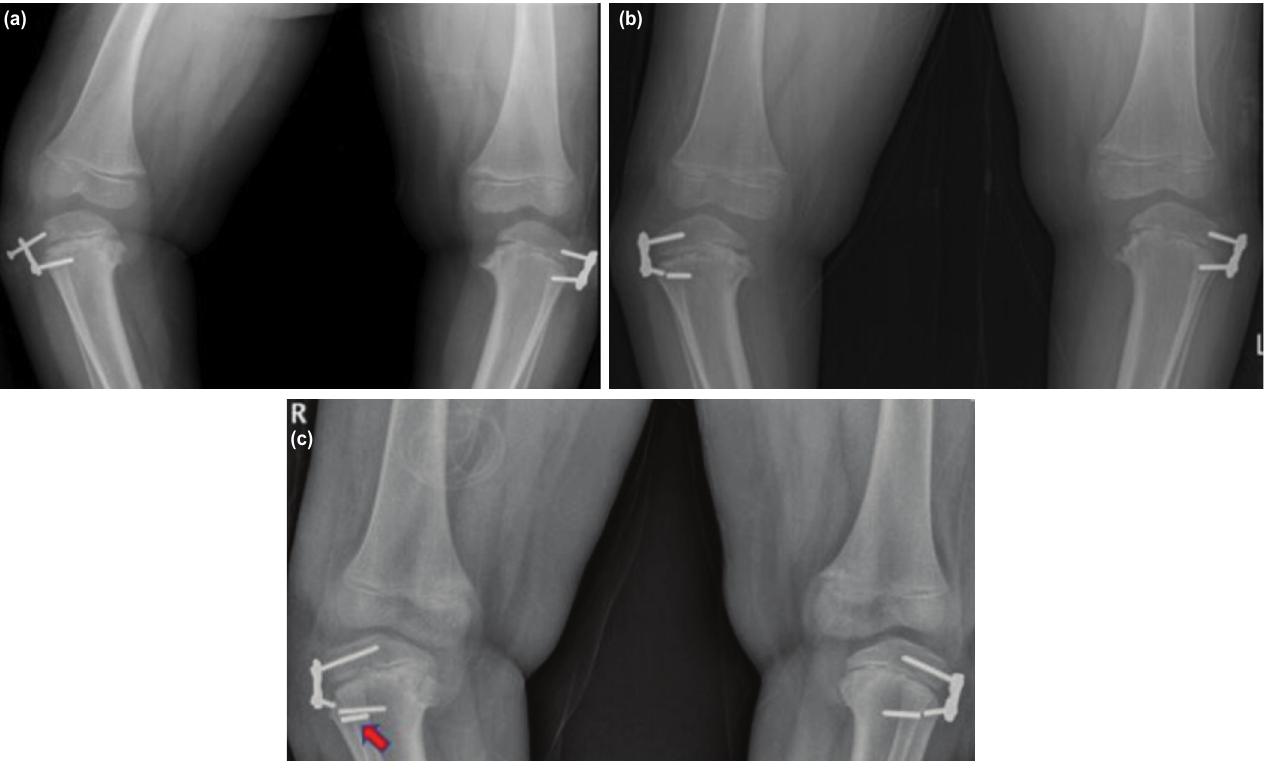
Radiographs of a 3-year-old boy with bilateral tibia vara and a BMI of 28 treated with reconstruction plates (Case 17). (a) Right Fig. 4: tibia epiphyseal screw pull-out six months after the primary surgery. Minimal divergence of left tibia screws, which appeared to be short. (b) After revision of the right tibia epiphyseal screw, the metaphyseal screw broke within 12 months. The screw- divergence on the left tibia was minimal. (c) The screws for both tibia were revised to longer ones, but both metaphyseal screws broke within nine months. The red arrow shows the broken end of a screw left from the previous